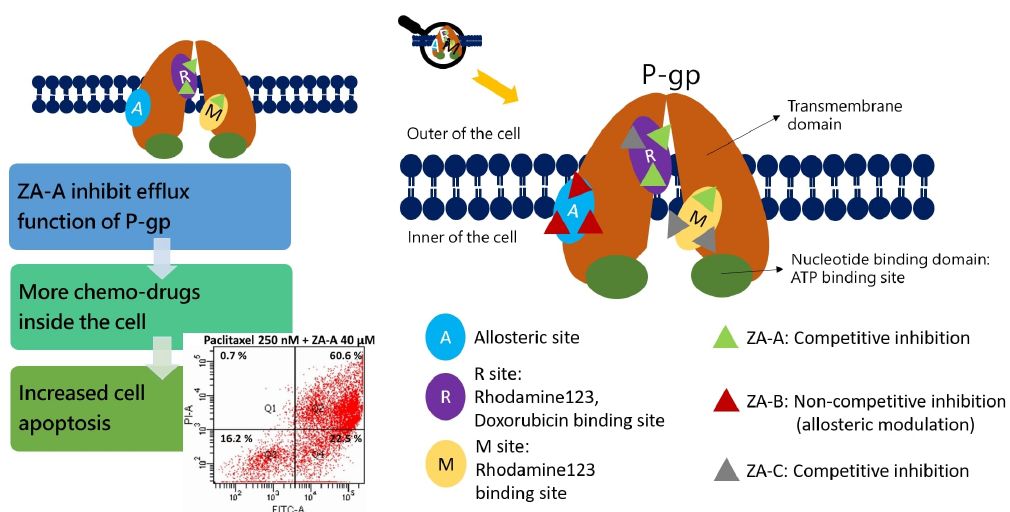
Figure 5. Summary of the P-gp inhibitory mechanisms and multidrug resistance (MDR) reversing effects of Zhankuic acids. ZA-A, ZA-B and ZA-C impacted P-gp efflux function through competitive, noncompetitive and competitive inhibitions, respectively. These effects resulted in increased intracellular concentration of chemo-drugs, rendering cell apoptosis.